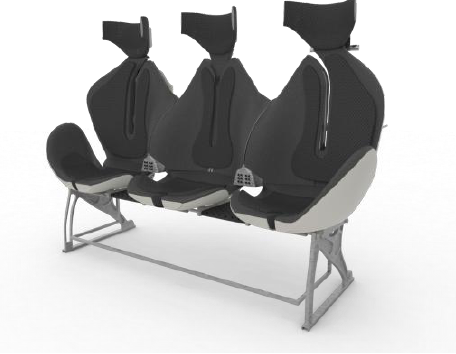
Figure 6. Eggshell inspired design.